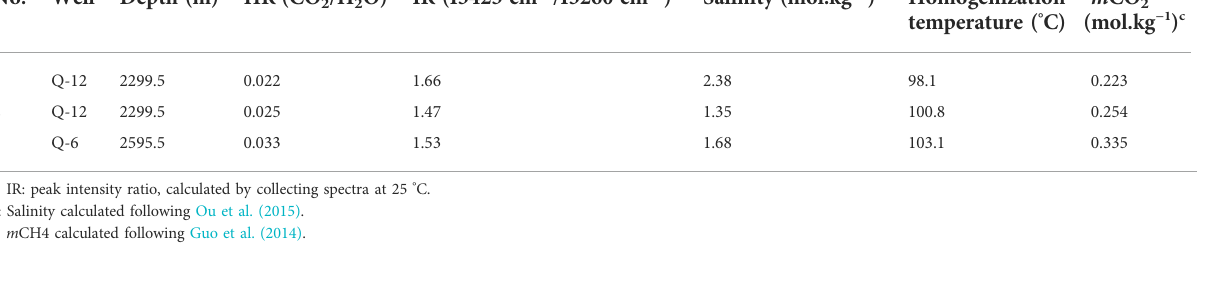
TABLE 4 Dissolved CO 2 in NaCl aqueous inclusions obtained by Raman quantitative analysis.